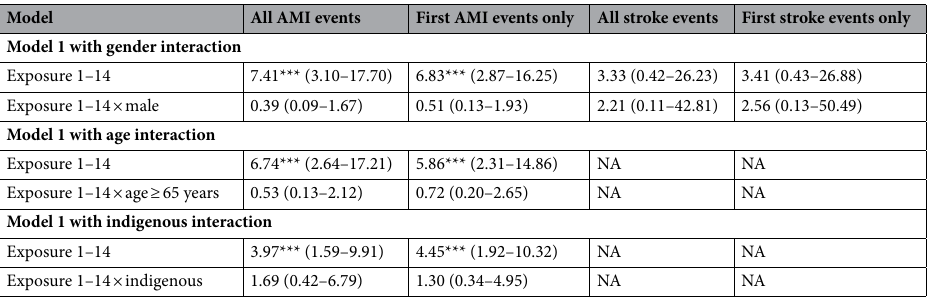
Table 3. Models with interaction for comparing relative incidence ratios for AMI/stroke after LRTI exposure among subgroups. ***Significant at 1%.